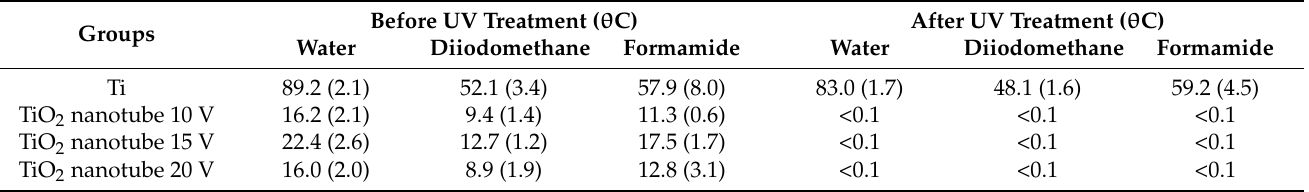
Table 4. Mean values and standard deviations (SD) of contact angle measurements. Values reported are degrees ( θ C).